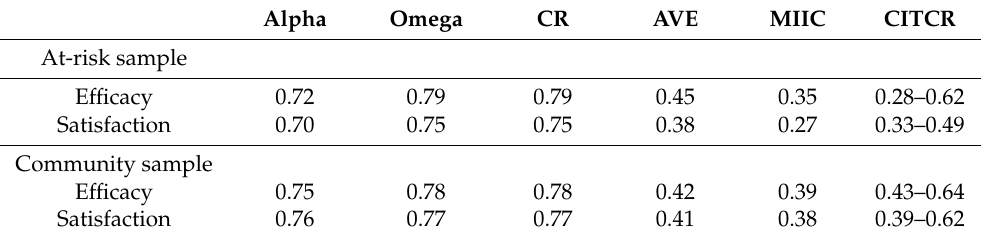
Table 4. Cronbach’s alphas, mean inter-item correlations, and corrected item–total correlation range.